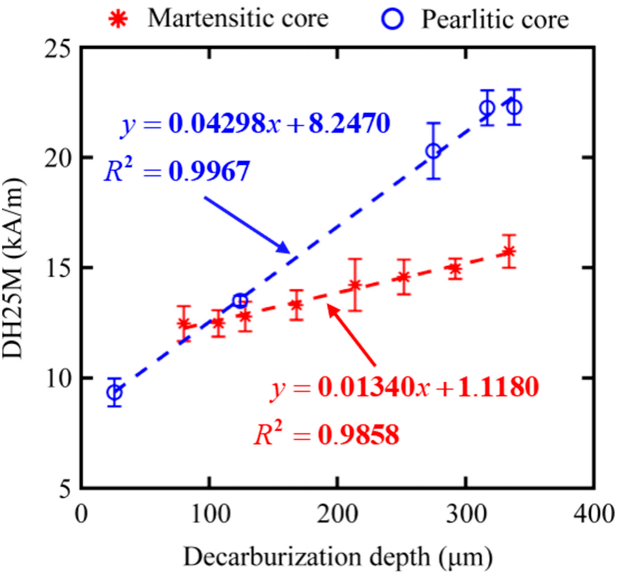
Figure 11. Dependencies of feature DH25M on the surface decarburization depths for all samples with martensitic and pearlitic cores.